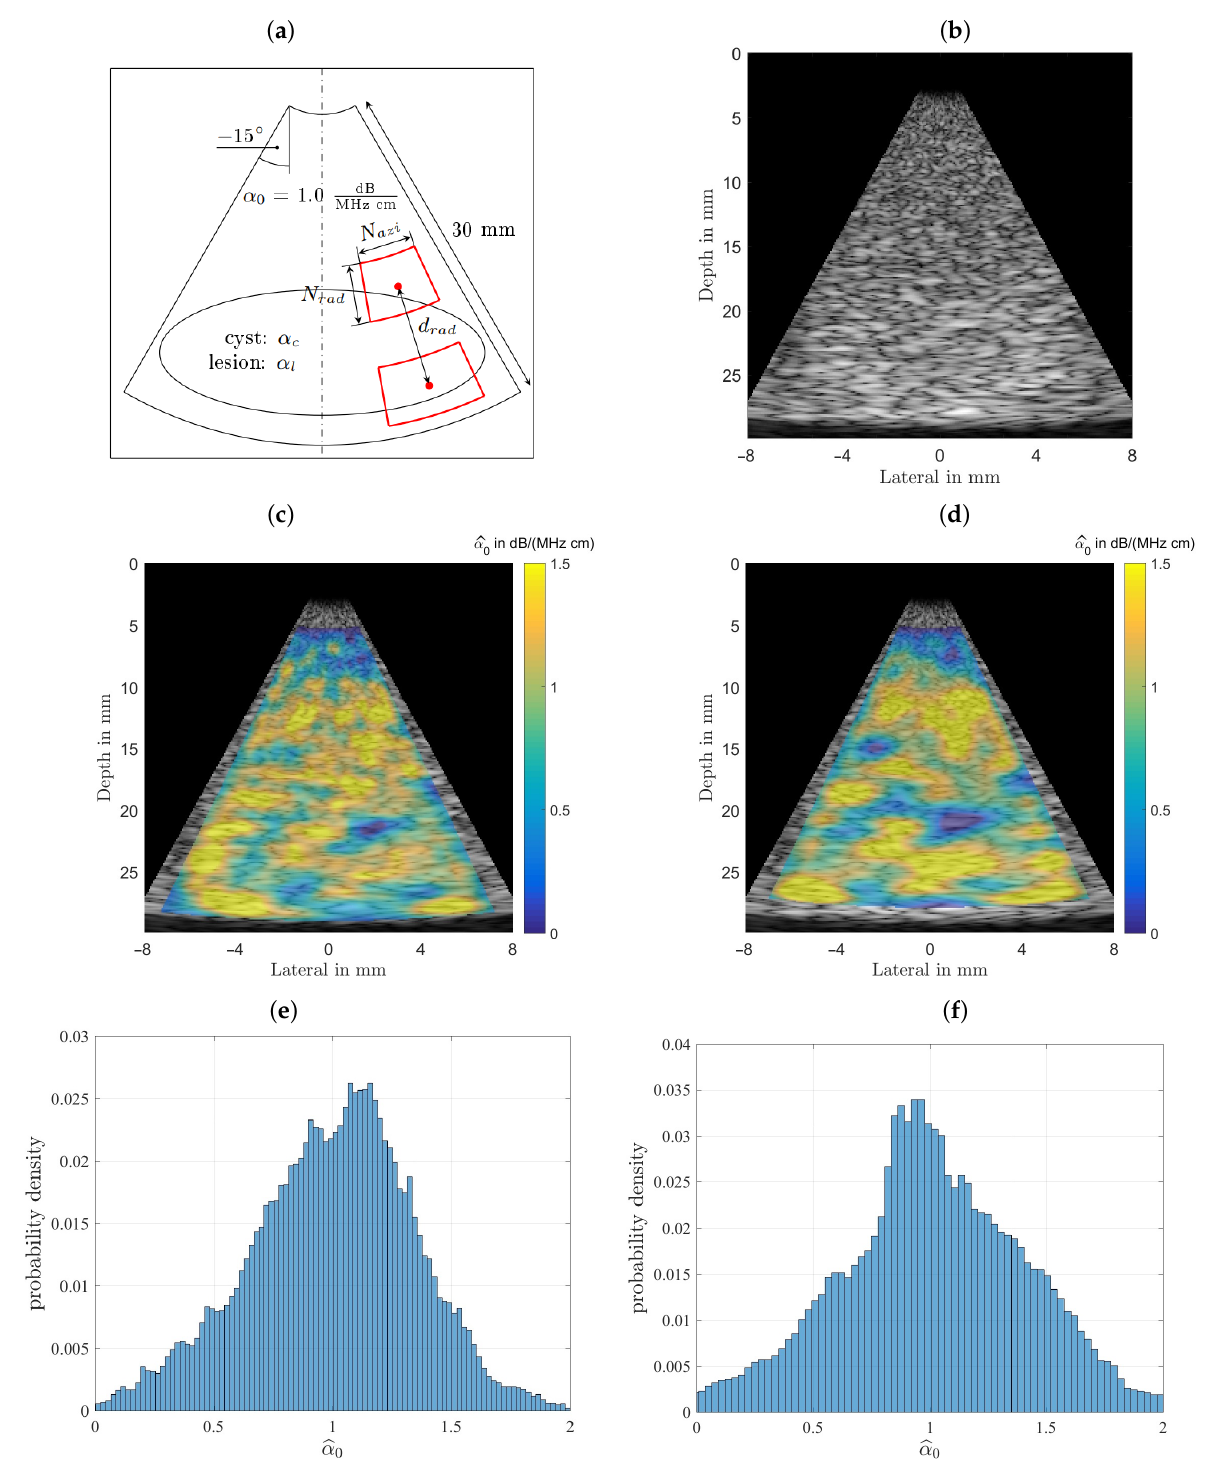
Figure 7. Comparison of the performance of both estimators. ( a ) The imaging geometry and the spectral density analysis windows. As a steering angle of ± 15 ◦ would appear very slim, the image was stretched to square, leading to speckles that appear wider than those seen in real ultrasound images. Furthermore, the distal and proximal windows are displayed larger than they actually are, to give an idea of what is done here, meaning there is not as much averaging done than could be assumed by inspecting the graphic. ( b ) Shows the simulated B-mode image rendered with correct time-gain-compensation. This raw data is analyzed by both attenuation estimating algorithms. ( c ) The color-coded overlaid estimation result for the spectral-log-difference algorithm. ( d ) Estimation result for the method-of-moments. ( e ) Probability density function for the spectral-log-difference algorithm. ( f ) Probability density function for the